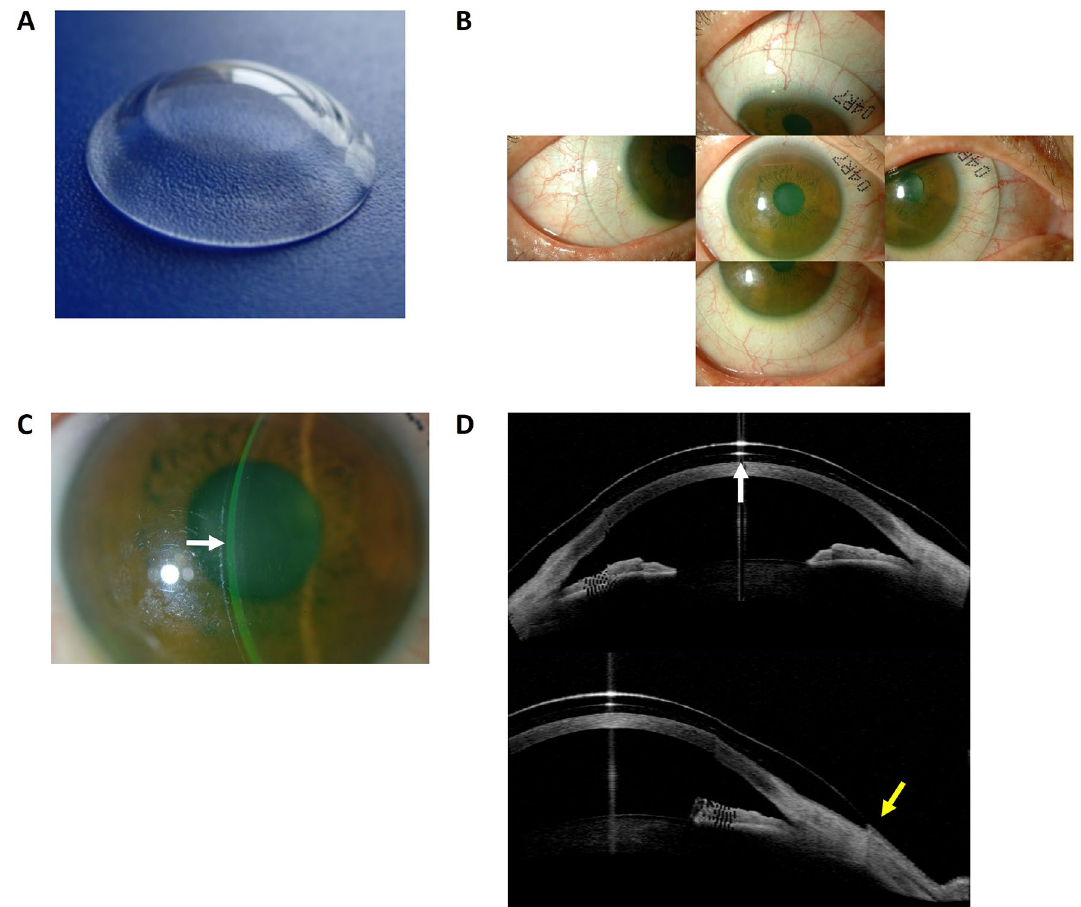
Figure 6. Individual LK scleral lens design and custom fitting. The LK scleral lens was custom-made ( A ) to fit each subject individually based on different ophthalmic examinations, including corneal topography and anterior segment optical coherence tomography. Absence of vascular compression at all gazes including primary position was confirmed under slit-lamp biomicroscopy examination ( B ). A tear-filled vault over the cornea of approximately half of the central corneal diameter was considered appropriate ( C ). Sagittal depth and overall LK scleral lens fitting were also assessed using anterior segment optical coherence tomography ( D ). White arrow indicates ideal tear reservoir over the cornea. Yellow arrow indicates absence of conjunctival vascular